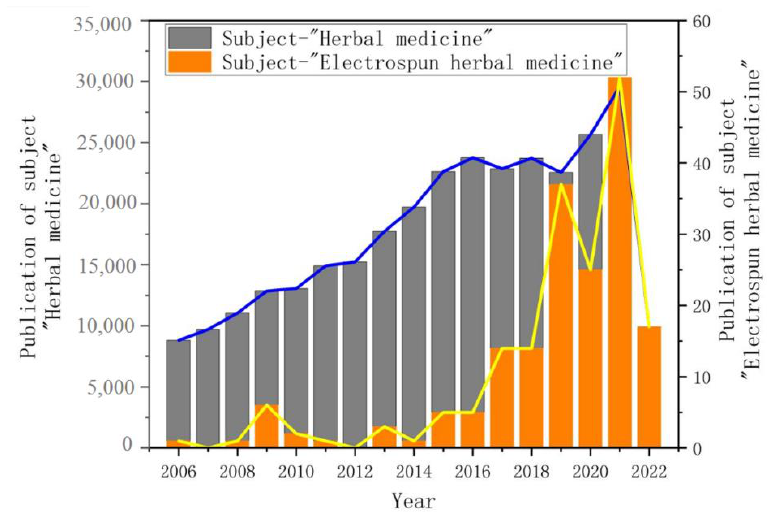
Figure 2. Statistics of literature retrieval from the “Web of Science” with keywords search on “Herbal Medicine” and “Electrospun Herbal Medicine”. Medicine” and “Electrospun Herbal